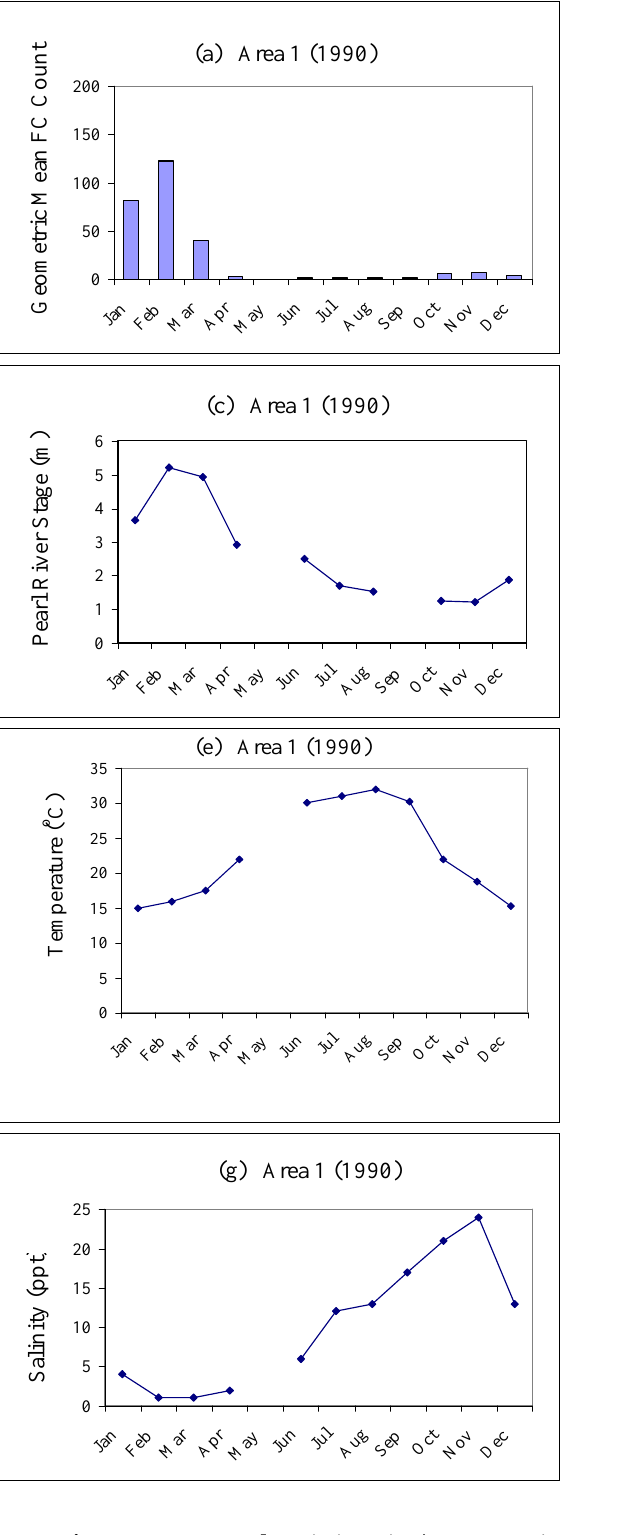
Figure 1: Seasonal variations in the geometric mean fecal coliform abundance, Pearl River stage, water temperature and salinity in the western part of Mississippi Sound in 1990 and 1992. Fecal coliform data were not collected in May 1990 and from May to July 1992. No Pearl River stage data was available in May and September 1990, and May to July, and September 1992. No data were collected for water temperature and salinity in May 1990 and from May to July